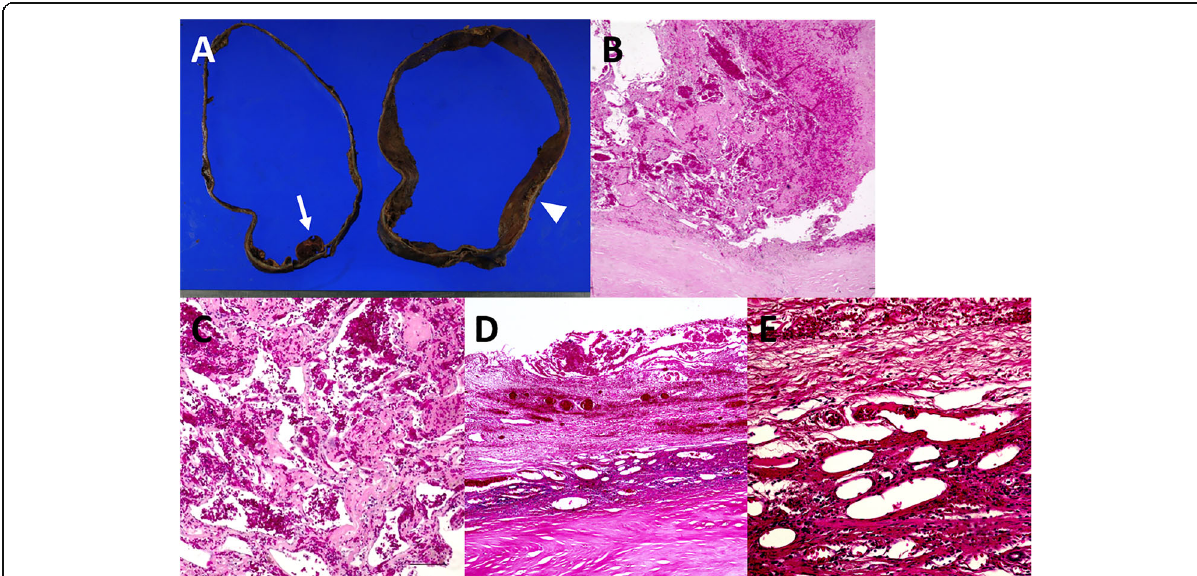
Fig. 4 Macroscopic and microscopic findings of the resected specimen. a (left-hand): Macroscopically, a dark-red solid protuberance was found in the cyst wall (arrow). a (right-hand): Macroscopically, a thickened portion of the cyst wall where the dorsal mural nodule seemed to have originally existed was detected (arrowhead). b , c Hematoxylin and eosin staining showed that the cyst wall mainly consisted of thick fibrous stroma and the ventral mural nodule consisted of several sizes of blood-filled vascular cavities surrounded by endothelial cells within the